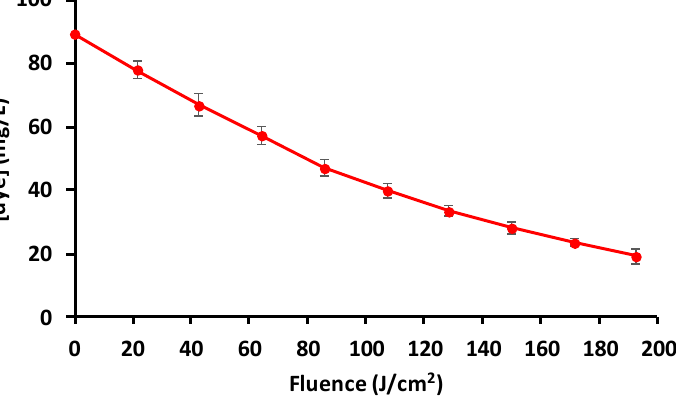
Figure 10. Decolourization of Direct Red 83:1 by an advanced oxidation process based on hydrogen peroxide and pulsed light. Bars mean standard deviations ( n = 3).